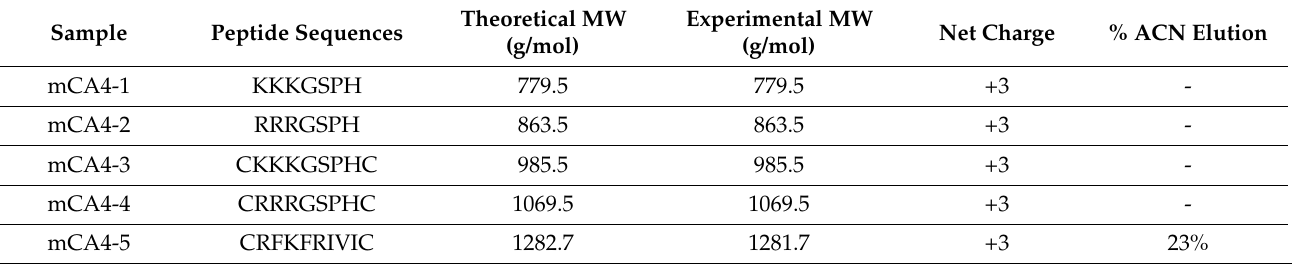
Table 1. Synthesized peptides and their key